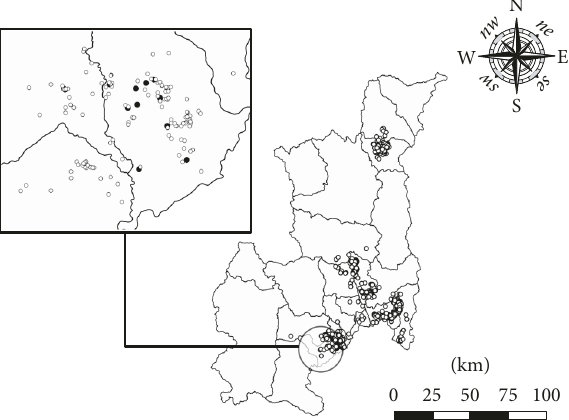
Figure 2: Locations of case- and control-farms in Chiang Mai province during 2011–2015. Circle indicates cluster of infected farms. Black dots indicate case-farms and white dots indicate control-farms.